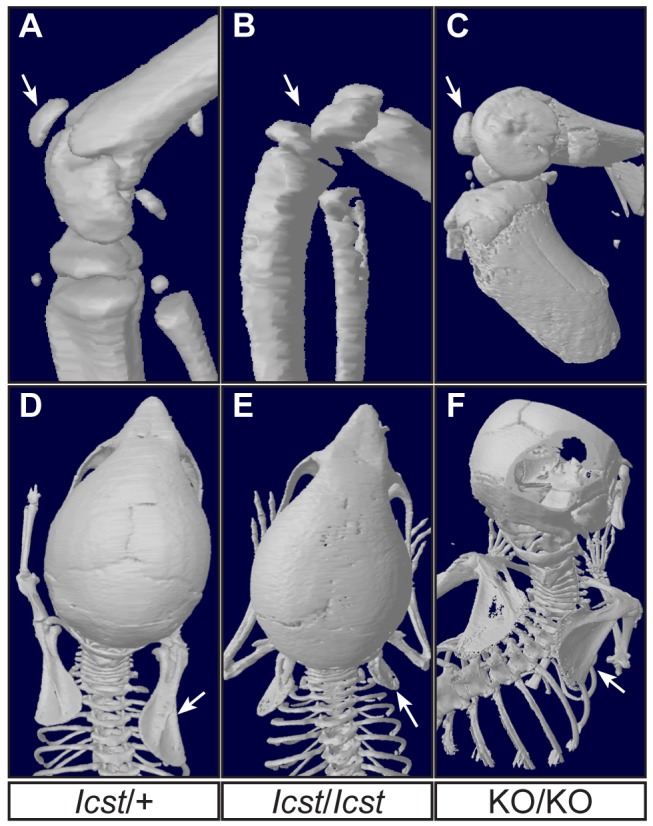
Patella and scapula phenotype of transgenic rescue mice.All mice shown are homozygous for the transgene. µCT scans of the patella and scapula are shown. (A) Lmx1bIcst
/+ (Icst/+) with normal patella (arrowed). (B) Lmx1bIcst
/Icst rescue (Icst/Icst) knee where the patella is absent (arrow indicates its expected location). (C) Lmx1bKO/KO rescue (KO/KO) knee where the patella is present (arrowed). (D) Normal scapula in Lmx1bIcst
/+ (arrowed). (E) The scapula is very underdeveloped and small in Lmx1bIcst
/Icst rescue (arrowed). (F) The scapula appears more normal in Lmx1bKO/KO rescue (arrowed). The ages of the mice shown are as follows; P23 (A, B, D, E), three months (C) and five weeks (F).